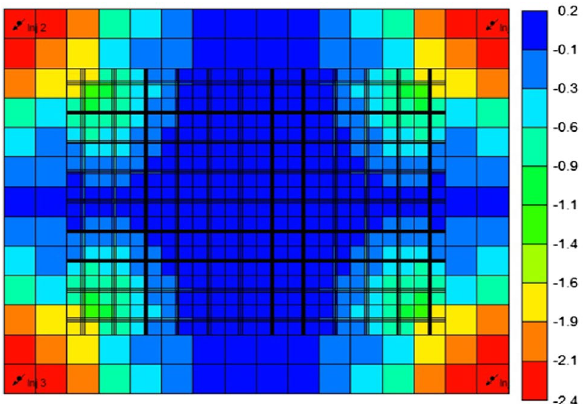
Fig. 5 Steady capillary pressure distribution after the production for 14 years